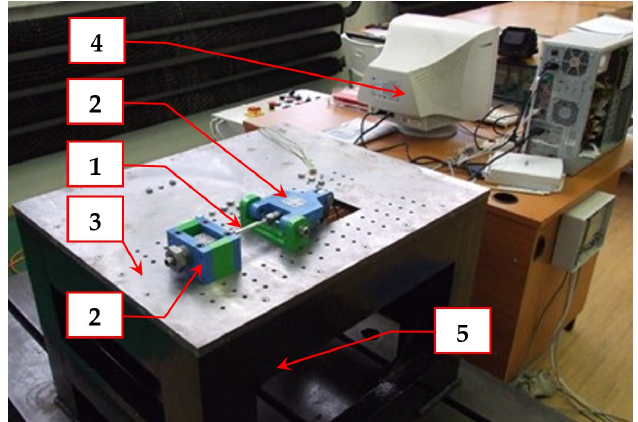
Figure 14. Multiaxial fatigue test system: 1—a specimen, 2—jaws for clamping a specimen, 3—a table (a support) of the test system, 4—a PC controlling and processing system, 5—acting compo- nents of the test system (under the table).